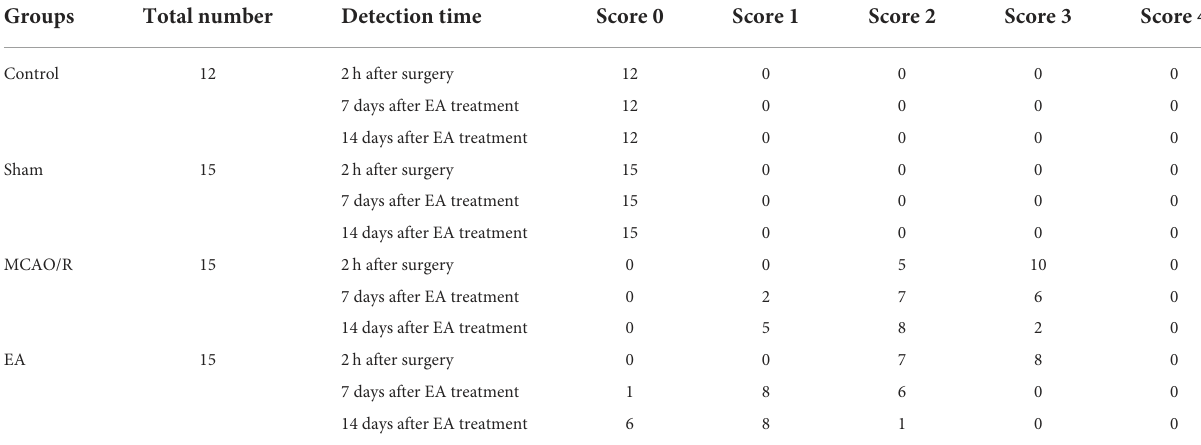
TABLE 1 Neurological deficit scores of rats in the four groups. Groups